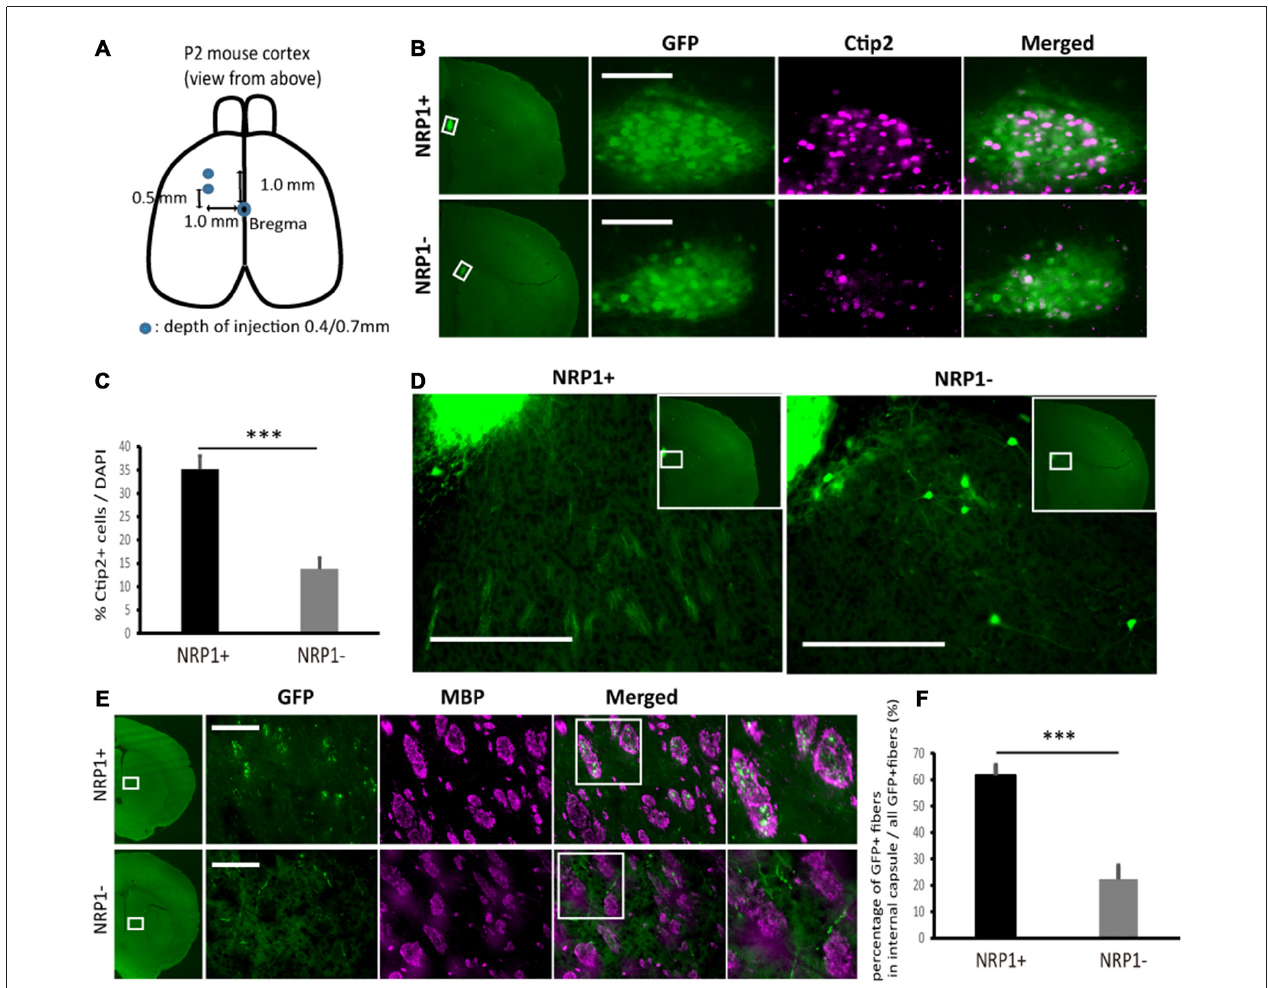
FIGURE 4 | Characterization of sorted cell-derived grafts and graft-derived neurites in fasciculated bundles in medial striatum. (A) Schematic of the transplantation. Cryoanesthetized pups were fixed on a bed, and cells (4.0 × 10 4 cells in total) were injected to the points (blue) depicted in the figure. (B) Immunostaining of representative grafts for GFP (green)/Ctip2 (magenta). Scale bars, 100 µ m. (C) Frequency of Ctip2 as a percentage of total DAPI stained cells in the graft. Values are the mean ± SEM. F ( 1,22 ) = 33.2, p < 0.0001 and ∗∗∗ p < 0.001 by one way ANOVA. (NRP1 + , n = 12; NRP1 − , n = 12). (D) Immunostaining of representative extension patterns of neurites around the grafts using the same section as that in Panel (B) . Scale bars, 100 µ m. (E) Representative images of GFP + neurites (green) in myelin positive fasciculated bundles (magenta) in the medial striatum. Scale bars, 100 µ m. (F) Frequency of GFP + fibers in the fasciculated bundles in the medial striatum (myelin basic protein (MBP) positive area, magenta) as a percentage of all GFP + cells in the same region. Values are the mean ± SEM. F ( 1,22 ) = 35.4, P < 0.0001. ∗∗∗ p < 0.001 by one way ANOVA. (NRP1 + , n = 12; NRP1 − , n =